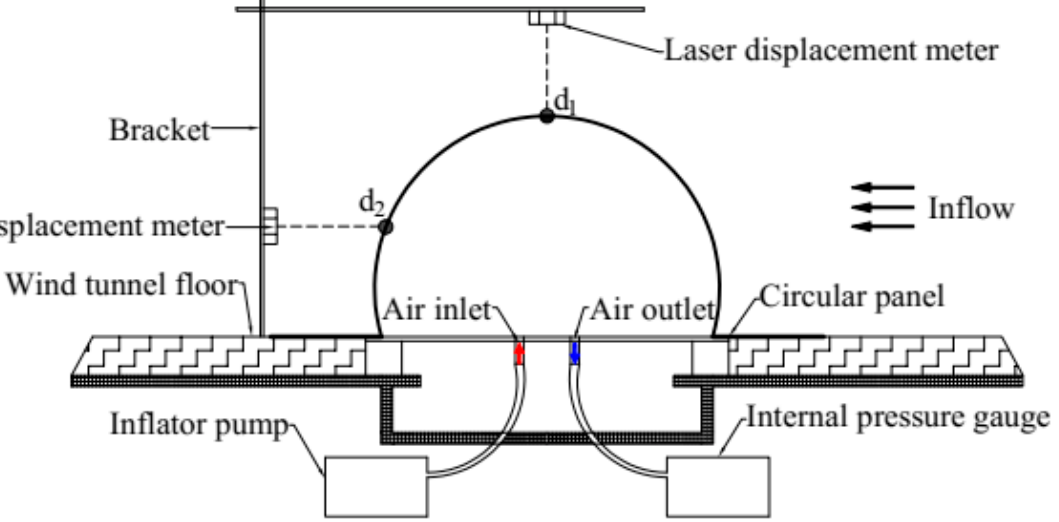
Figure 2. The diagram of model installation and measuring point.